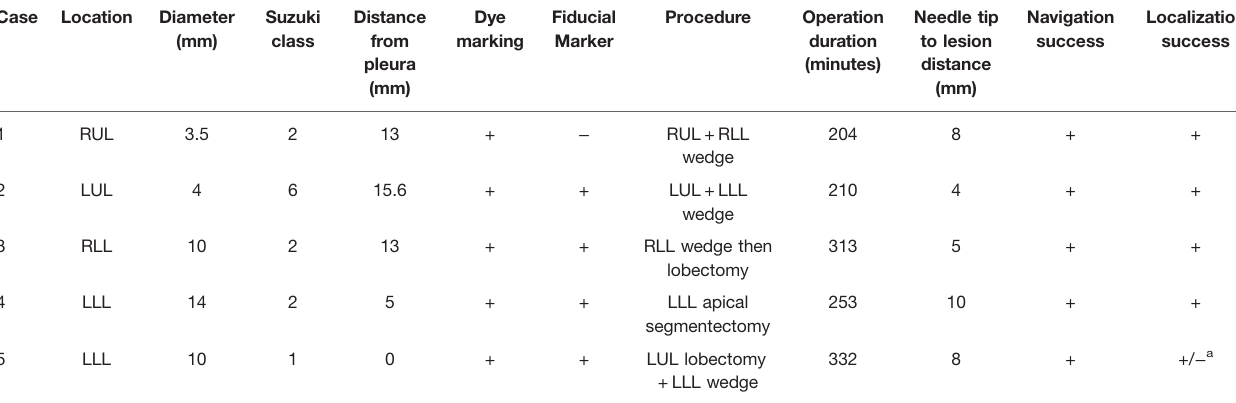
TABLE 1 | Baseline characteristics and clinical outcomes of robotic bronchoscopy ICG dye marking cases. Case